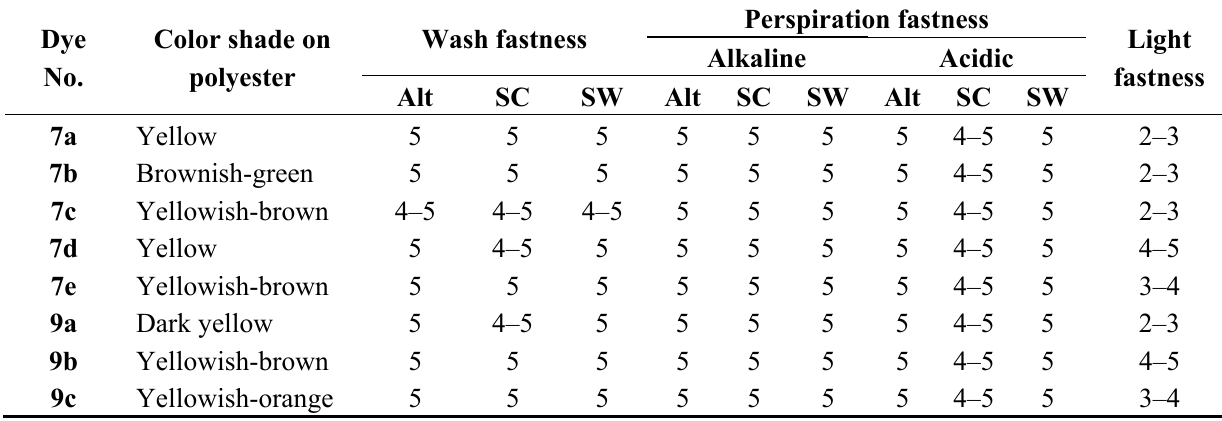
Table 2. Fastness properties of monoazo compounds on polyester fabrics